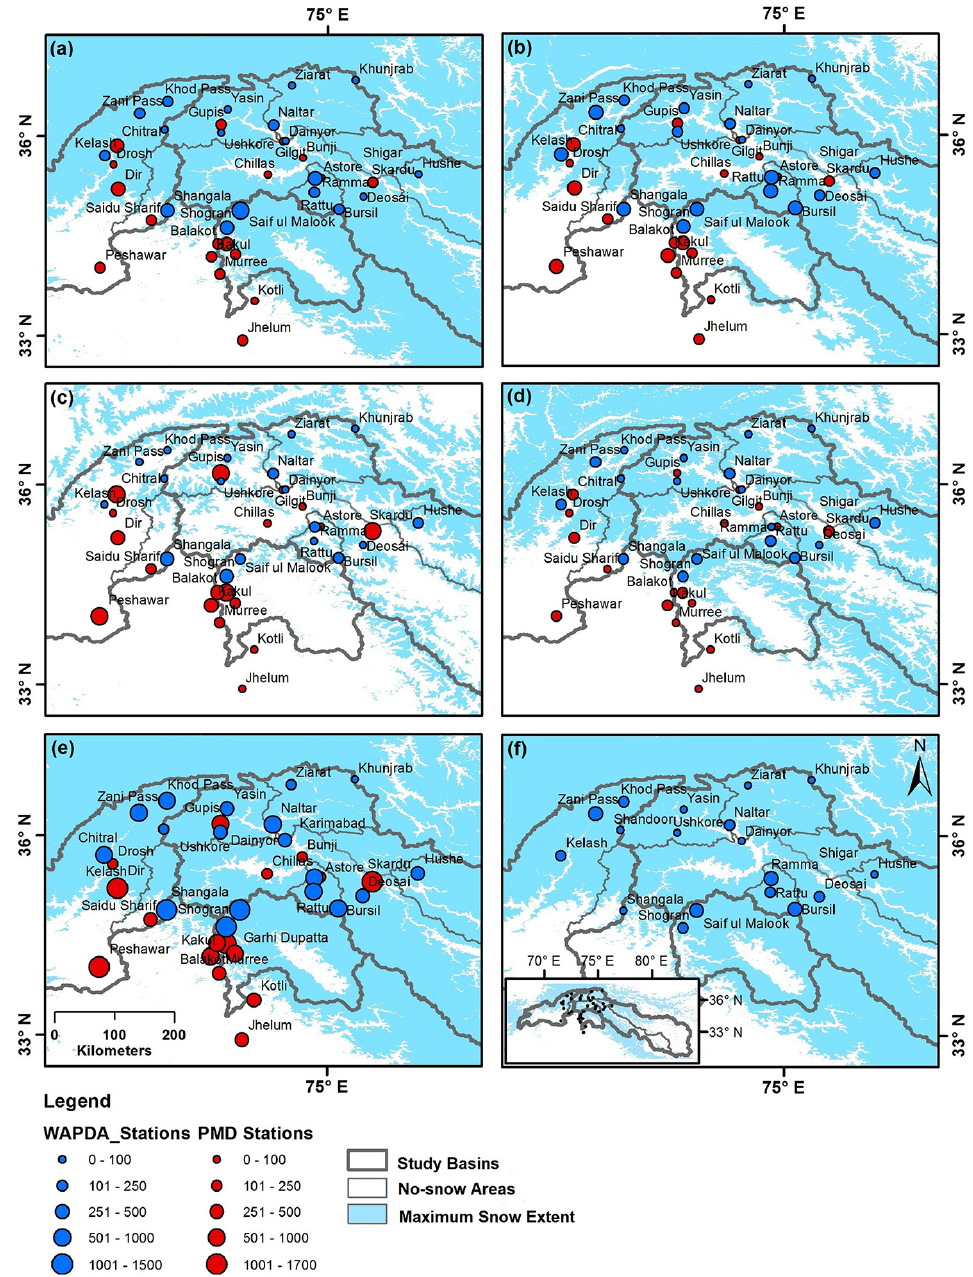
Figure 8. Seasonal and annual precipitation climatology from low-altitude (below 2200ma.s.l.) PMD stations (1995–2010) and from high- altitude stations (above 2200ma.s.l.) WAPDA stations (1995–2012) for: (a) winter, (b) spring, (c) summer, (d) autumn, (e) annual,